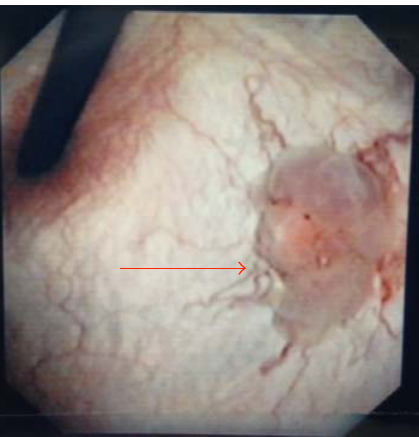
Figure 1: Initial flexible cystoscopic finding. A two-centimeter nonpapillary bladder mass was found at the bladder base with surrounding hypervascularization (arrow).